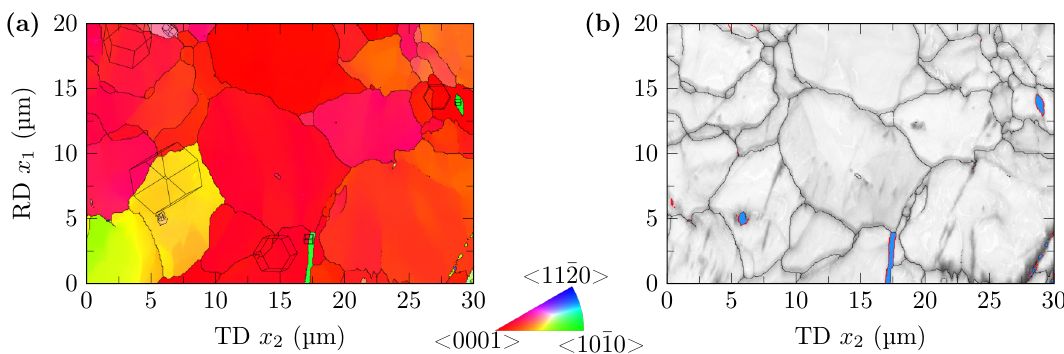
10¯12 tension twins: ( a ) EBSD orientation map with view in ND from the hot-bent { } 5.0 ) °), marked with blue color. ±